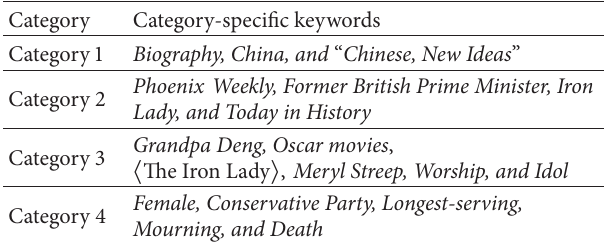
Table 1: Category-specific keywords on the event of “The death